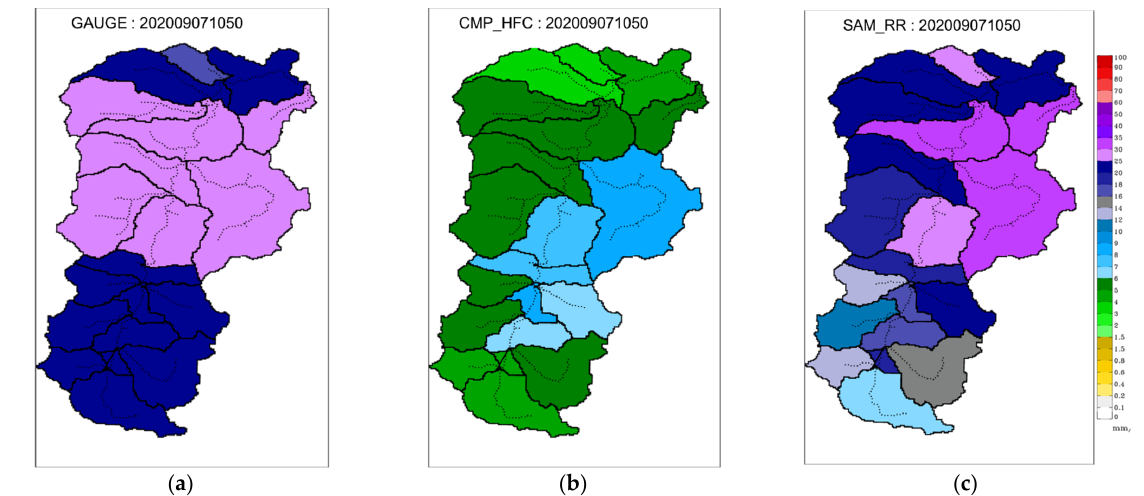
Figure 13. Calculation results of the flood forecast information for 7 September 2020, at 10:50: ( a ) Ground rain gauge; ( b ) CMP_HFC; ( c ) SAM_RR.